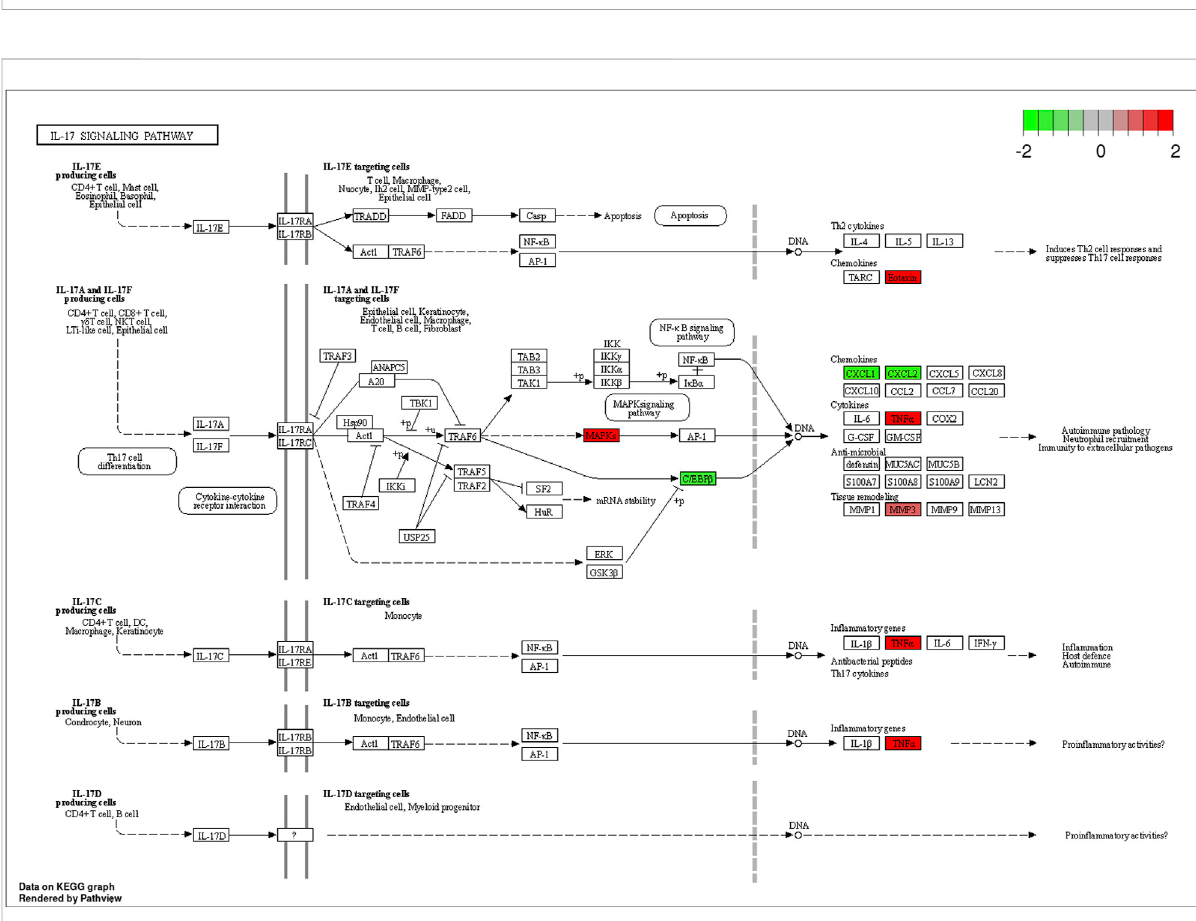
FIGURE 5 Differentially expressed genes enriched in the path diagram of the IL-17 signaling